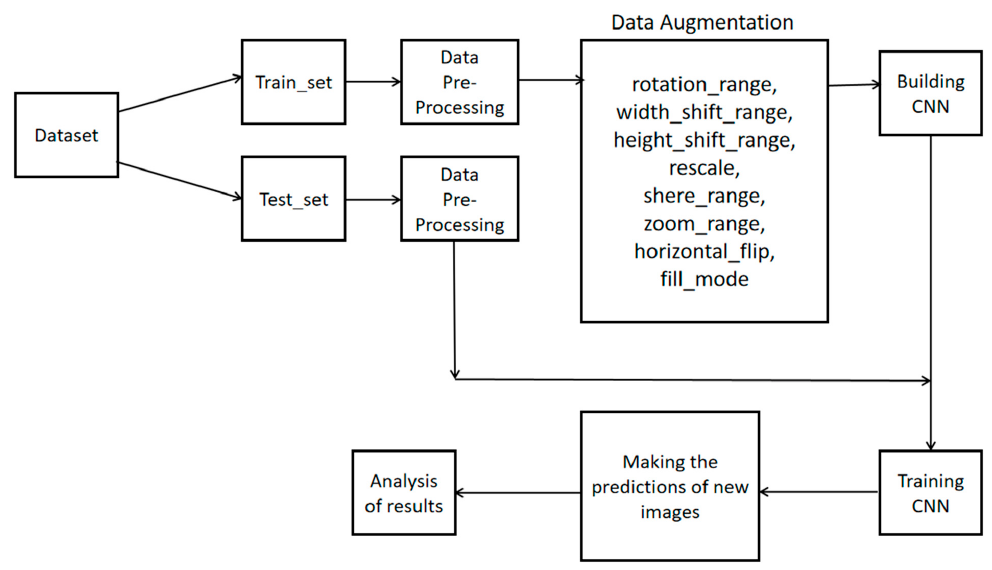
Figure 4. The overall framework of building the model.